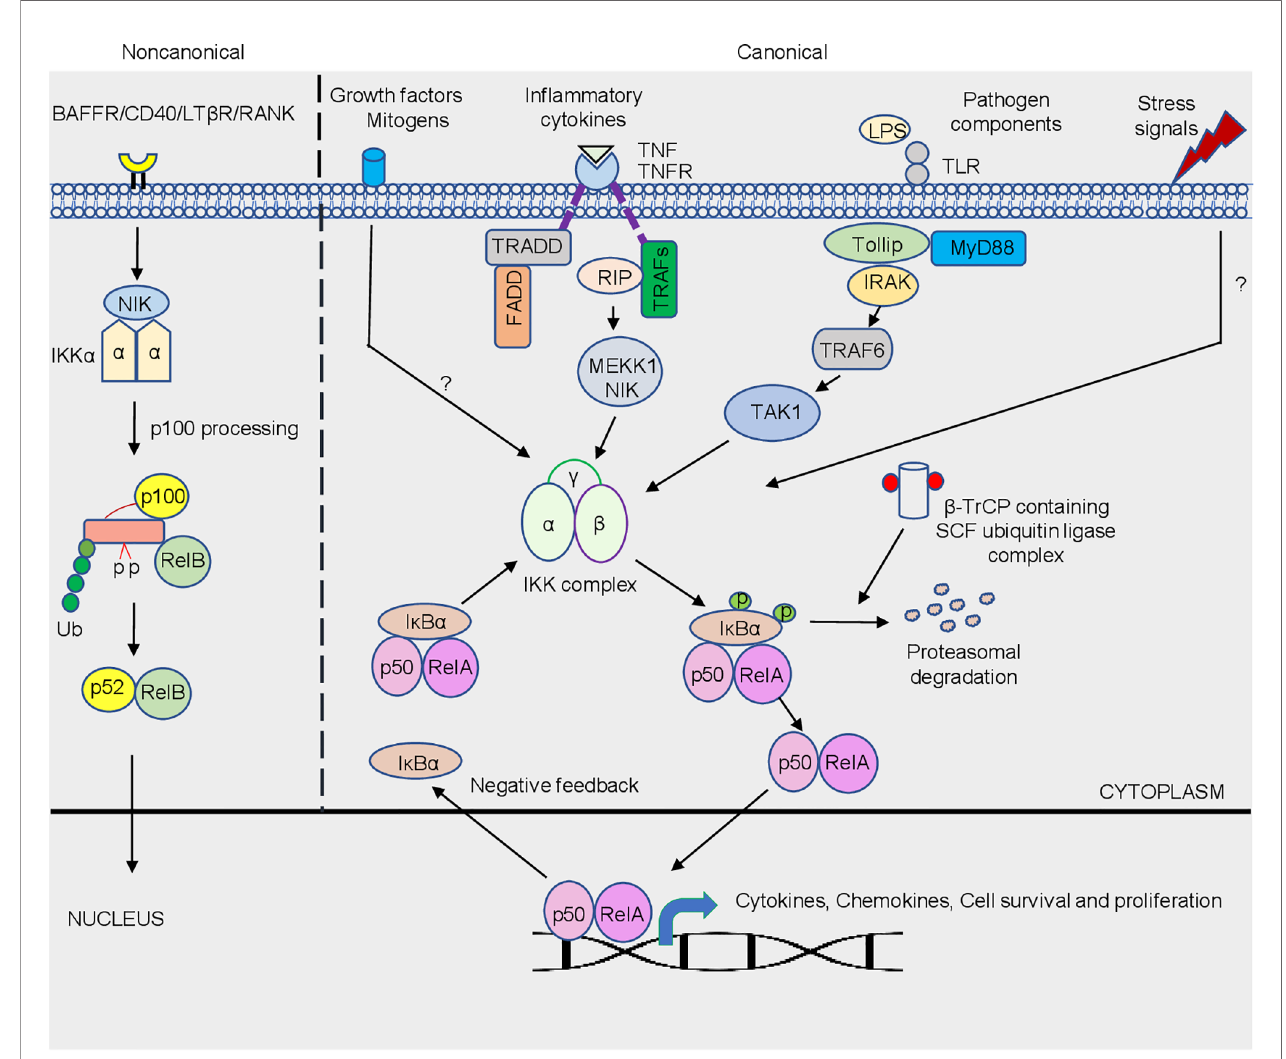
FIGURE 1 | Schematic representation of the canonical and non-canonical NF- k B signaling pathway. The canonical pathway is activated by a plethora of trigger/ stimuli that includes different pathogens, stress signals, growth factors and in fl ammatory cytokine exposure which converges on the IKK complex. Activation of the NF- k B is tightly regulated due to the sequestration of the complex by I k B a in the cytosol. Phosphorylation of I k B a via IKK is a signal for its degradation, which is mediated by b -TrCP containing SCF-ubiquitin ligase complex. Freed dimers subsequently translocate to the nucleus where they bind to k B elements that controls the transcriptions of a variety of genes, which includes genes responsible for cytokine, chemokines, cell survival and proliferation. The non-canonical NF- k B pathway is dependent on the phosphorylation-induced p100 processing triggered by signaling from a subset of TNFR members. This pathway is reliant on NIK and IKK a , but not on the trimeric IKK complex, and mediates the activation of RelB/p52 complex. The detailed pathway is described in